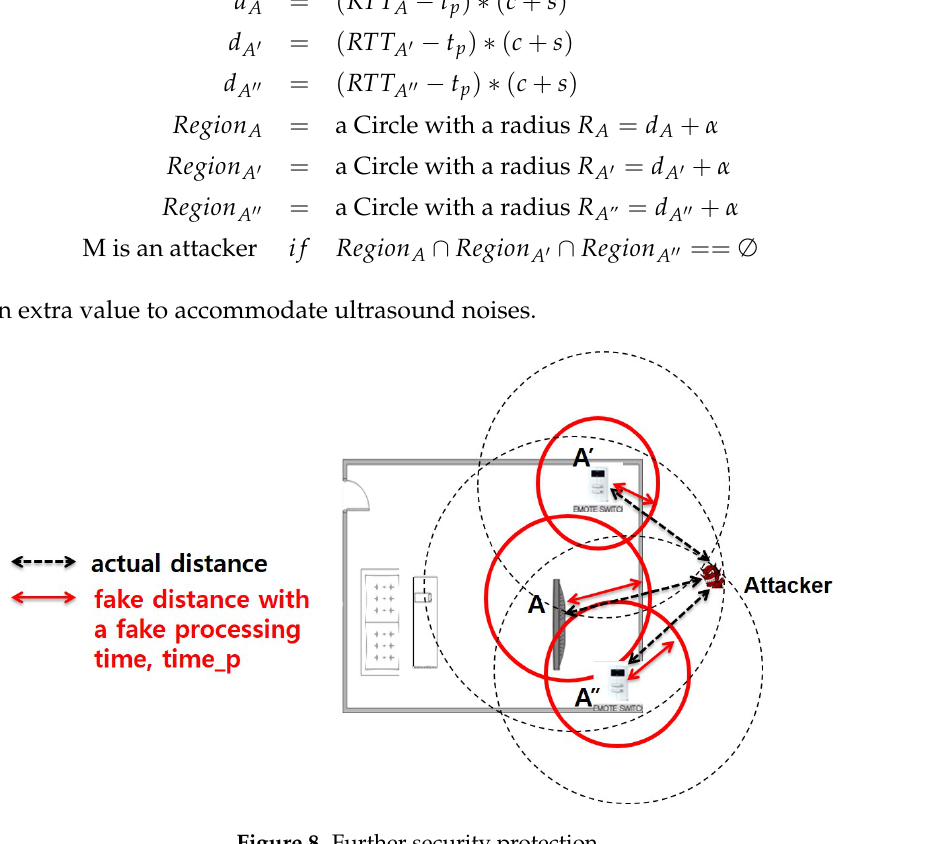
Figure 8. Further security